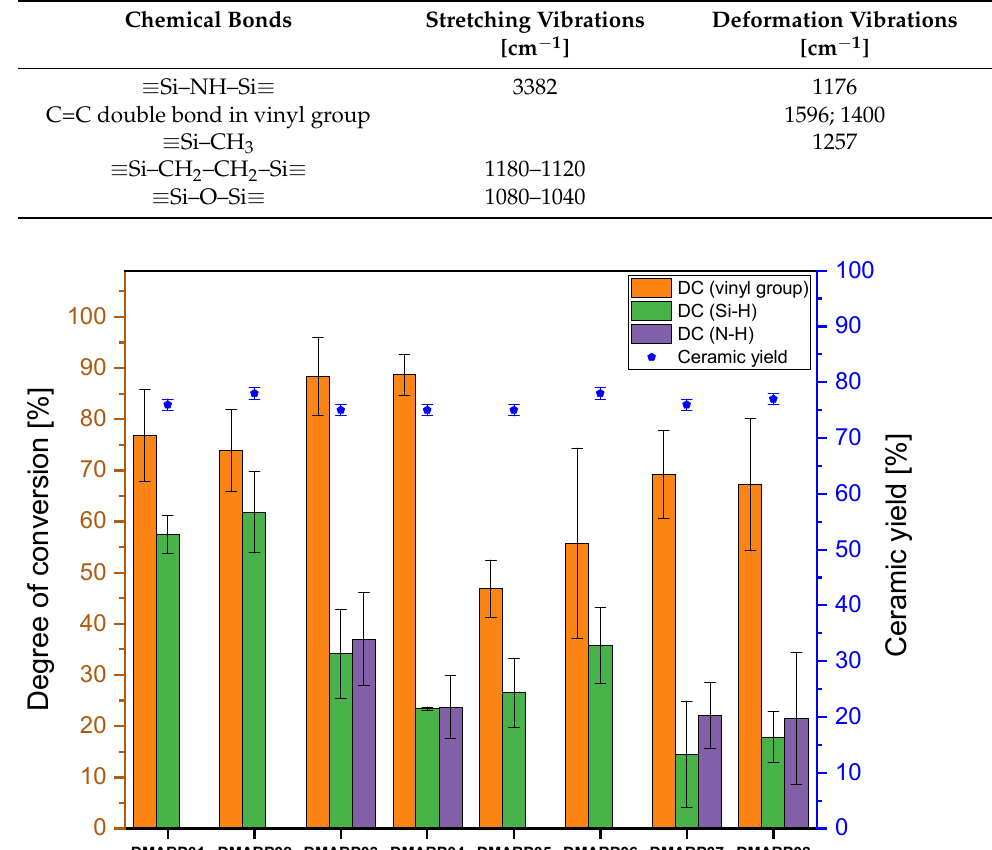
Figure 8. Degree of conversion (DC) of the reactive vinyl group as well as Si–H and N–H bonds calculated from the FTIR spectra of the samples DMABP 01–08. The ceramic yield was obtained by thermogravimetric analysis (TGA) measurement at 1200 °C.